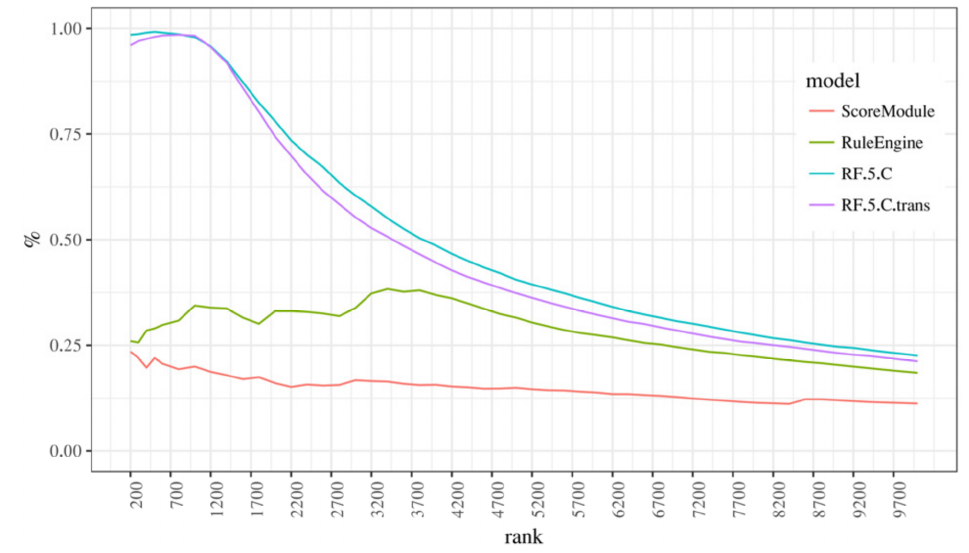
Figure 6. Ranked precision chart for the RF.5.C and baseline